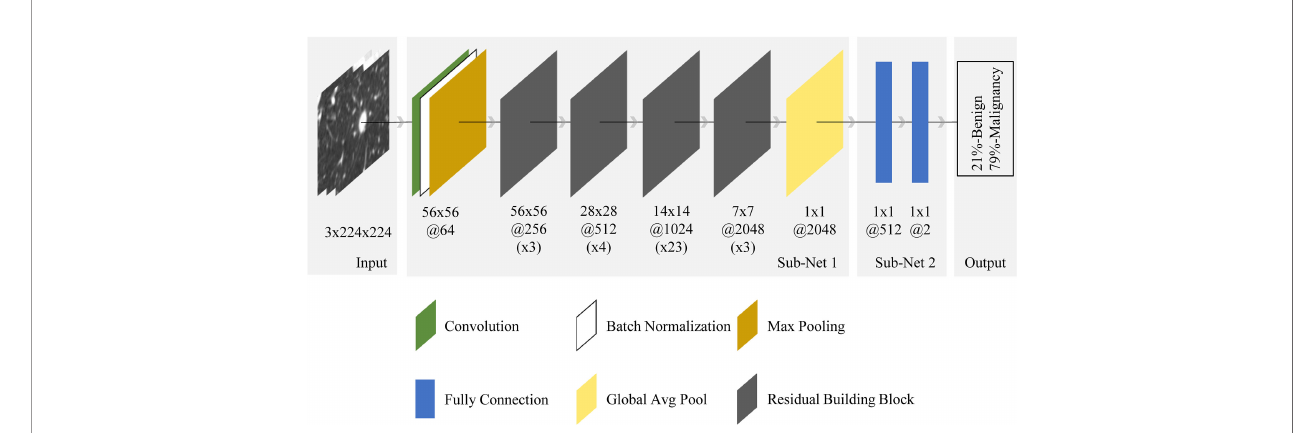
FIGURE 4 | End-to-end CNN model illustration. For the input nodule images (from the left side), the neural network made the prediction (right side) and outputted two values, representing benign and malignant probabilities (summed to 1). The fi nal diagnosis of each nodule by the model depended on which class was predicted with a probability greater than 50%. The architecture was composed of convolution, batch normalization, max pooling, fully connection, global average pooling, and residual building block. Sub-net 1 was pretrained on ImageNet dataset with ~15 million neutral images, while sub-net 2 was trained from scratch. The 56x56@256 (x3) below the fi rst residual building block meant the spatial size and number of channels of the output feature map in this block were 56x56 and 256 respectively, while x3 meant the block contained 3 residual